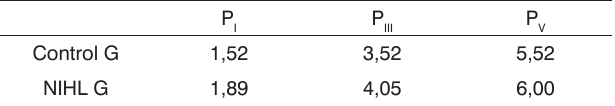
Table 4. Distribution of the absolute latencies of PI, PIII and PV of the right ear, in both groups and the p value by the Mann-Whitney test.